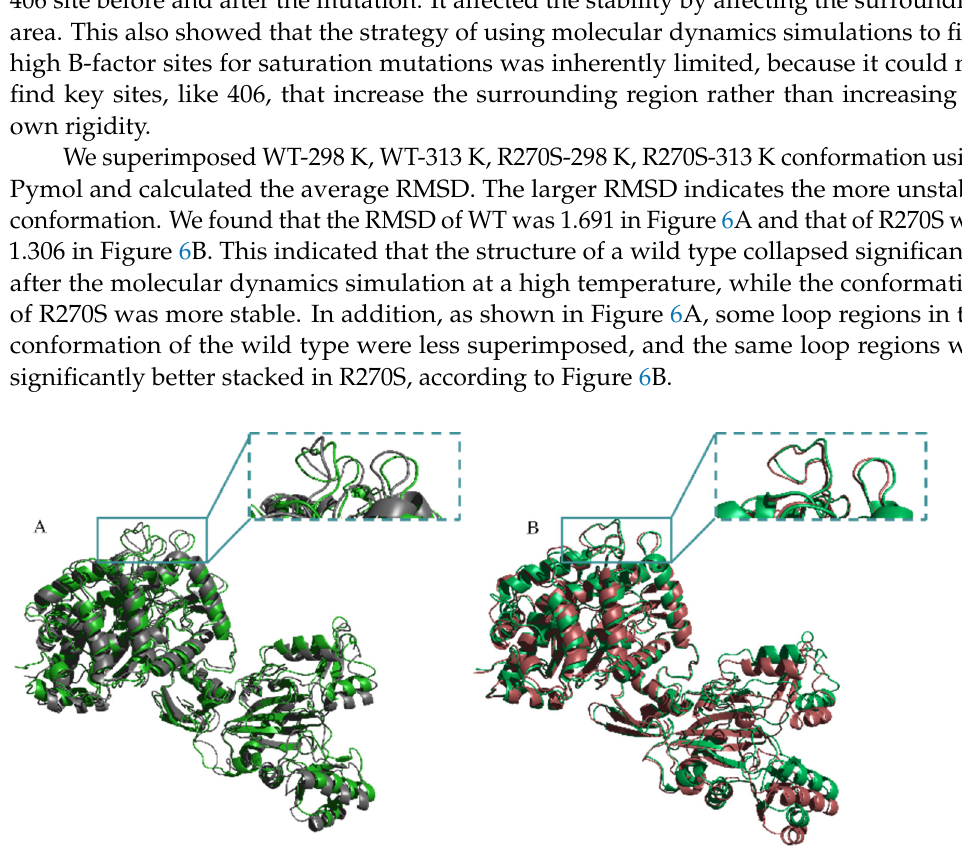
Figure 5. RMSD and RMSF values of WT, R270S and Q406M at 313 K. ( A ) RMSD values of GshFSA-